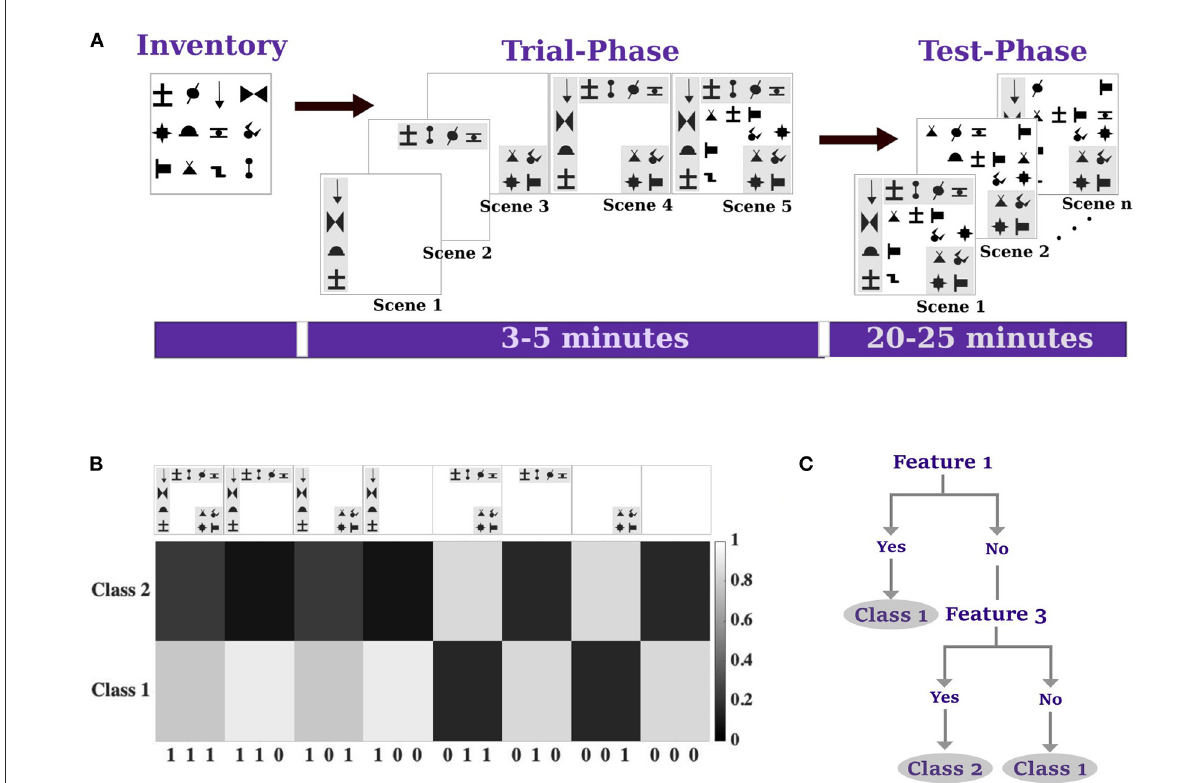
FIGURE2 Experimental paradigm and design. (A) Inventory of stimulus symbols used. Scenes 1–3 show the three different stimulus features that could be each present or absent in each stimulus. The other symbols were used as distractors. The trial phase was used to familiarize subjects with the stimuli. Example stimuli used in the test phase for learning and testing. (B) Eight possible stimulus types indexed by binary triplets to indicate the presence of stimulus features and the associated expected utility given by the probability that the stimulus belongs to Class 1. (C) A decision tree that represents the optimal response for the utility function in (B) . Under time pressure the decision tree is simplified by replacing the analysis of the third feature by the decision for Class 2.